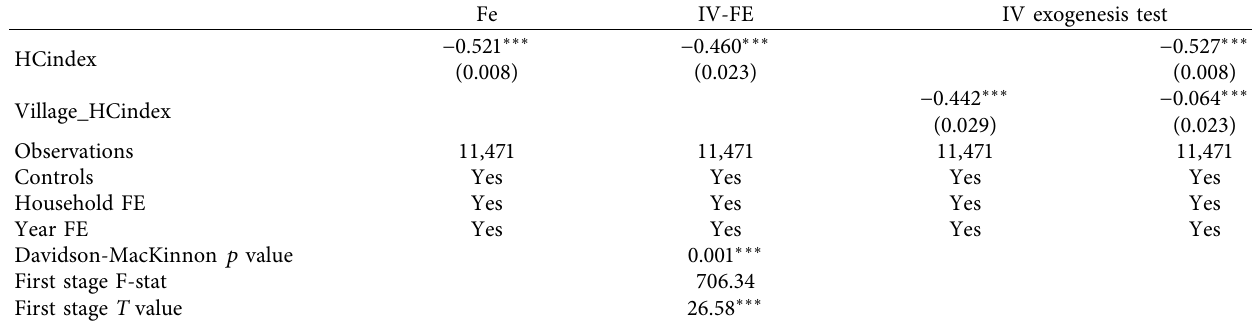
Table 5: Endogeneity analysis.